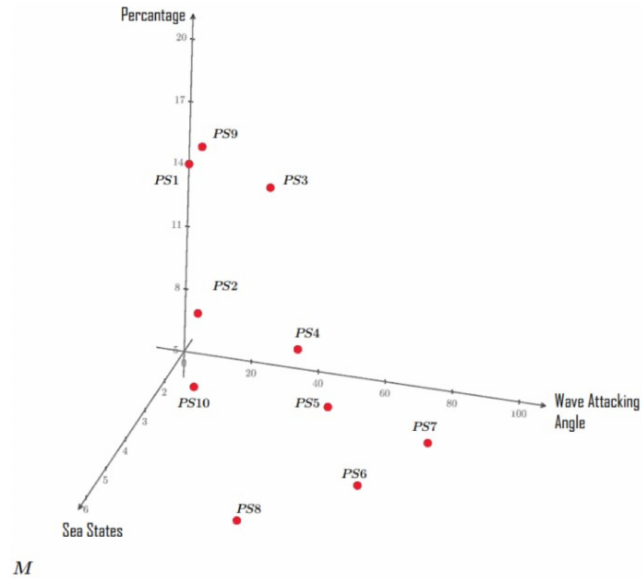
Figure 13. Possible scenarios Mathcad 3D scatter view.